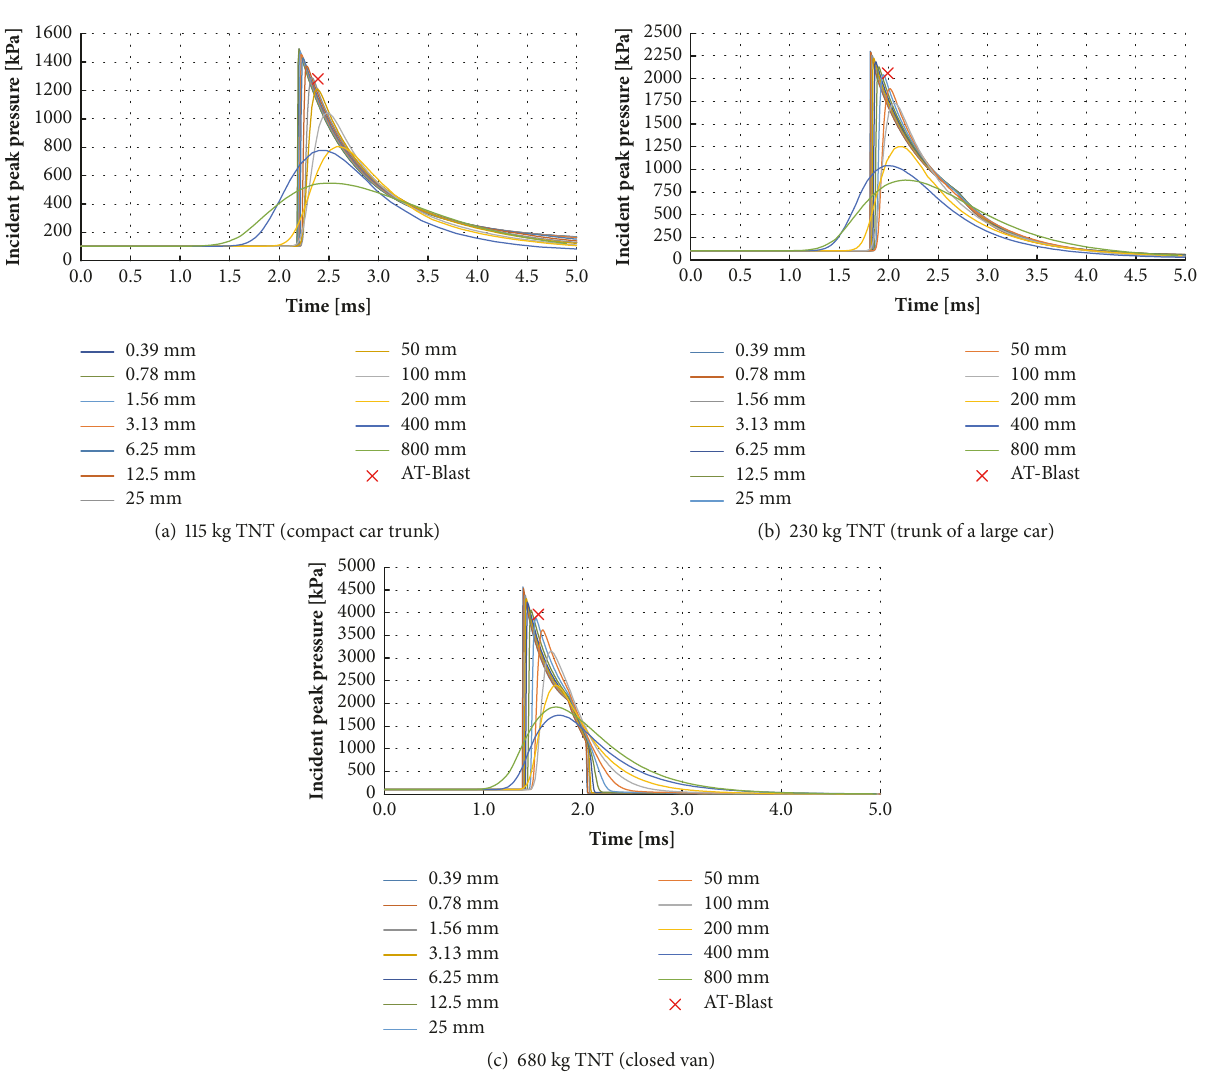
Figure 4: Pressure-time histories for analysed TNT